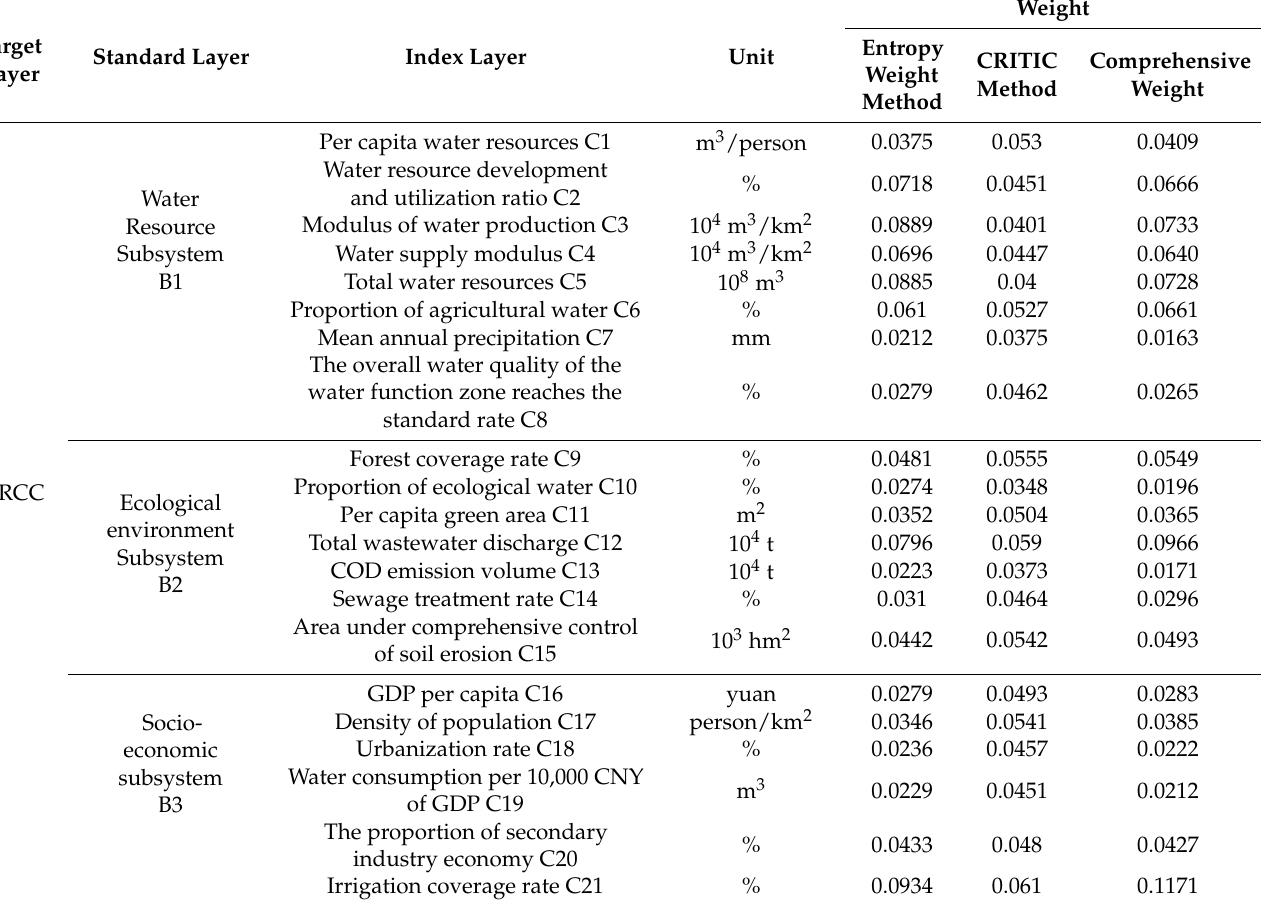
Table 1. Evaluation index system of WRCC in